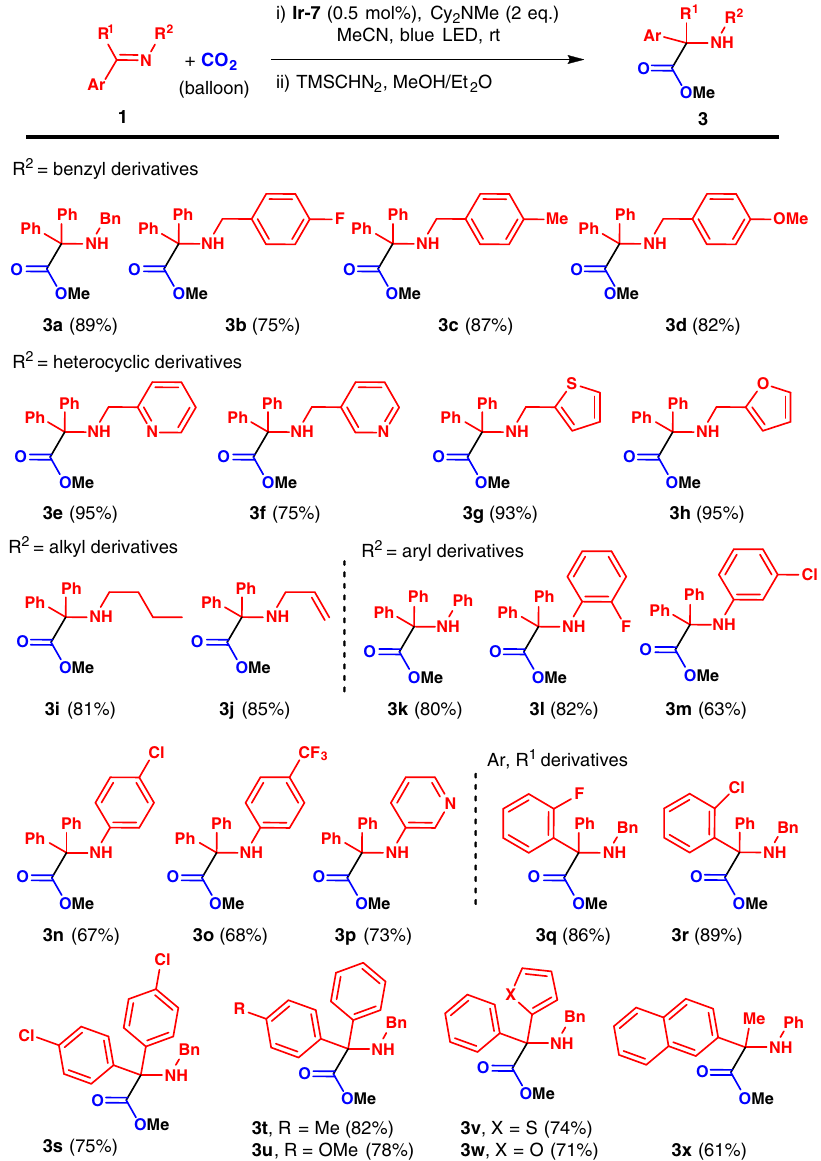
2-F or 2-Cl substituted aryl reacted smoothly with CO 2 to give the α -amino esters 3q and 3r in 86% and 89% yield, respectively. The 4,4 ′ -dichloro derivative 1s afforded the amino ester 3s in 75% yield. The electron-donating 4-Me and 4-OMe groups on the benzophenone imines did not affect their reactivity. The desired products were obtained in 82% for 3t and 78% for 3u . Heterocyclic substrates were also tolerated. The 2-thiophenyl and 2-furanyl substrates reacted with CO 2 to yield the hydrocarboxylation products 3v and 3w in 74% and 71% yield, respectively. To our delight, the alkyl ketimine derived from 2- naphthylmethyl ketone reacted with CO 2 to afford 3x in 61% yield (catalyst loading 2 mol%). However, attempts to perform the hydrocarboxylation of N -phenyl dimethylketimine failed, yielding a complex mixture with no observation of the desired product.